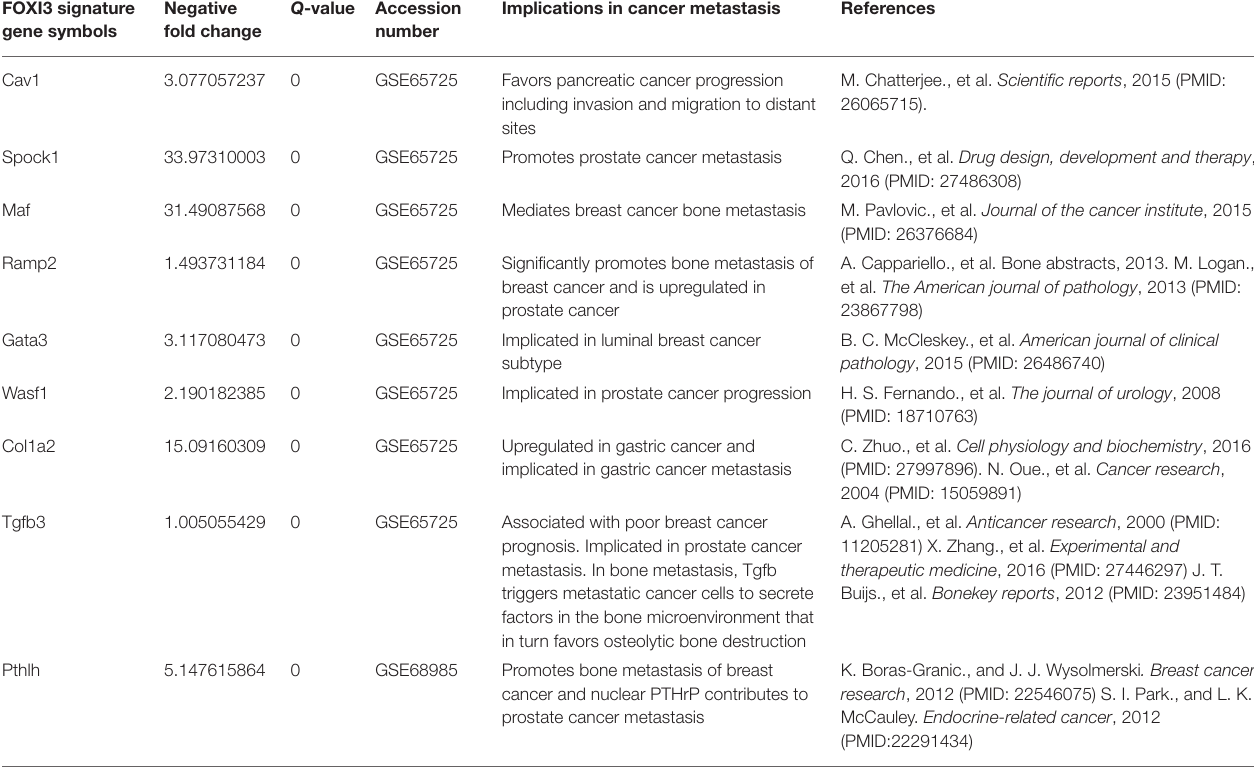
TABLE 2 | Role of FOXI3 signature genes in cancer